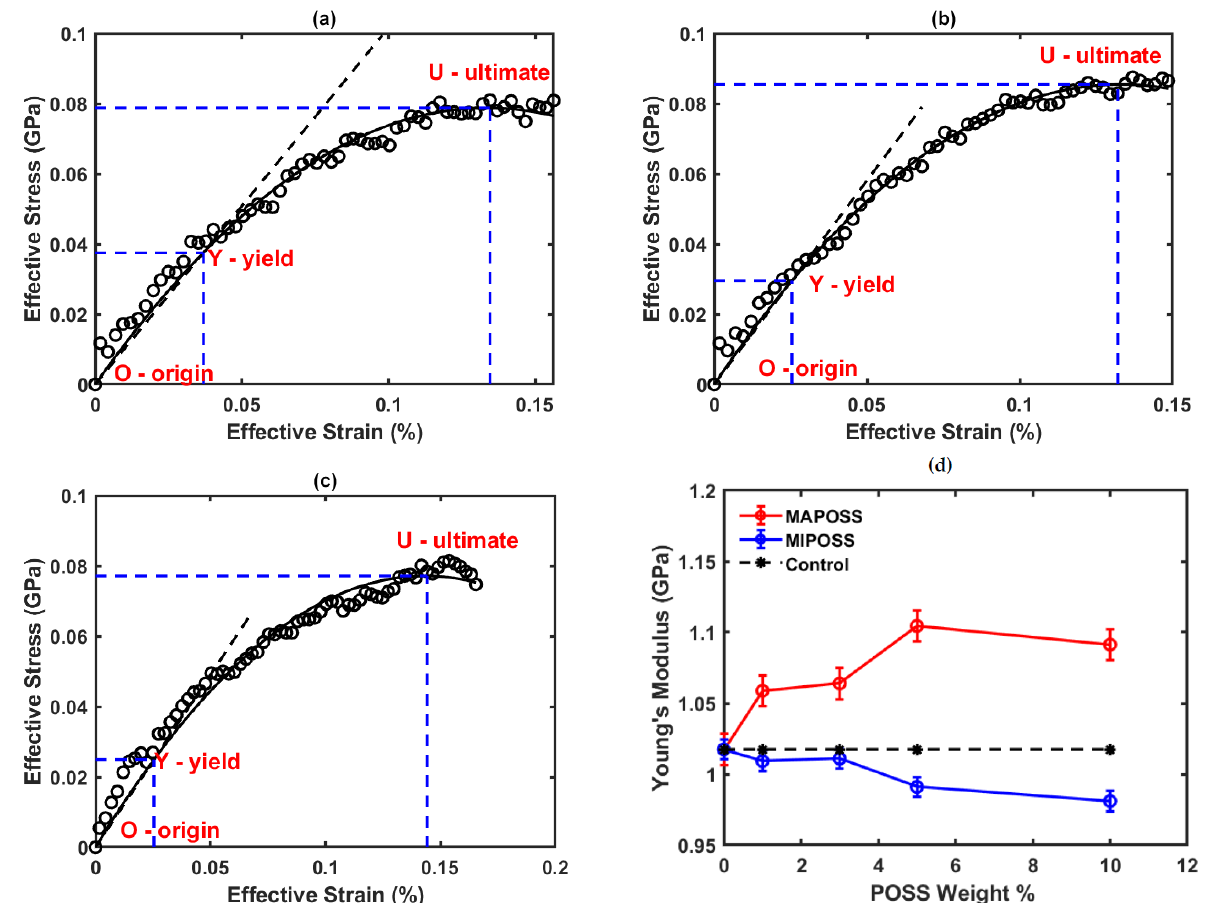
Figure 7. Effective stress vs. strain for ( a ) Control ( b ) MAPOSS10 and ( c ) MIPOSS10, ( d ) Young’s modulus vs. POSS wt% for all composites.